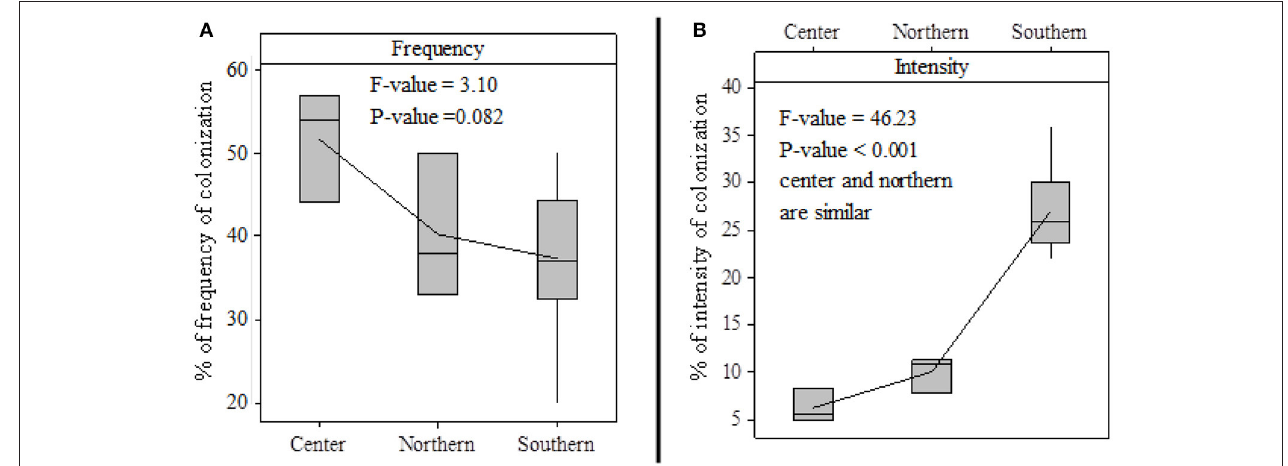
FIGURE 6 | Boxplot of mycorrhization across study areas: frequency of colonization (A) ; intensity of colonization (B)